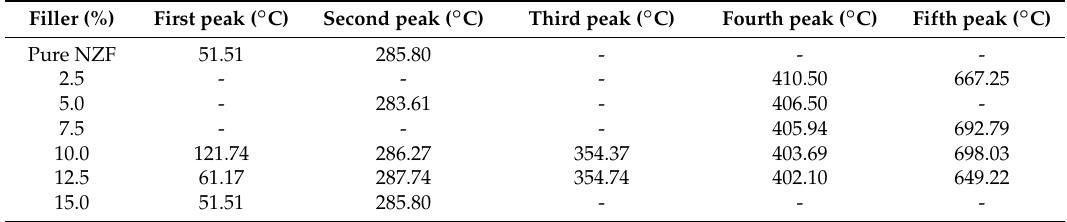
Table 2. Summary of DTG degradation temperatures of NZF + OPEFB + PCL composites with various NZF wt % contents.